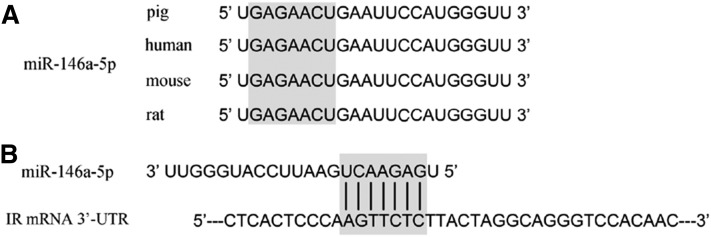
Conserved analysis of miR-146a-5p and its target gene across species. A: Mature sequences of miR-146a-5p in the pig, human, mouse, and rat genomes. Gray area denotes seed sequences. B: Binding site of IR mRNA 3′-UTR and miR-146a-5p seed region.